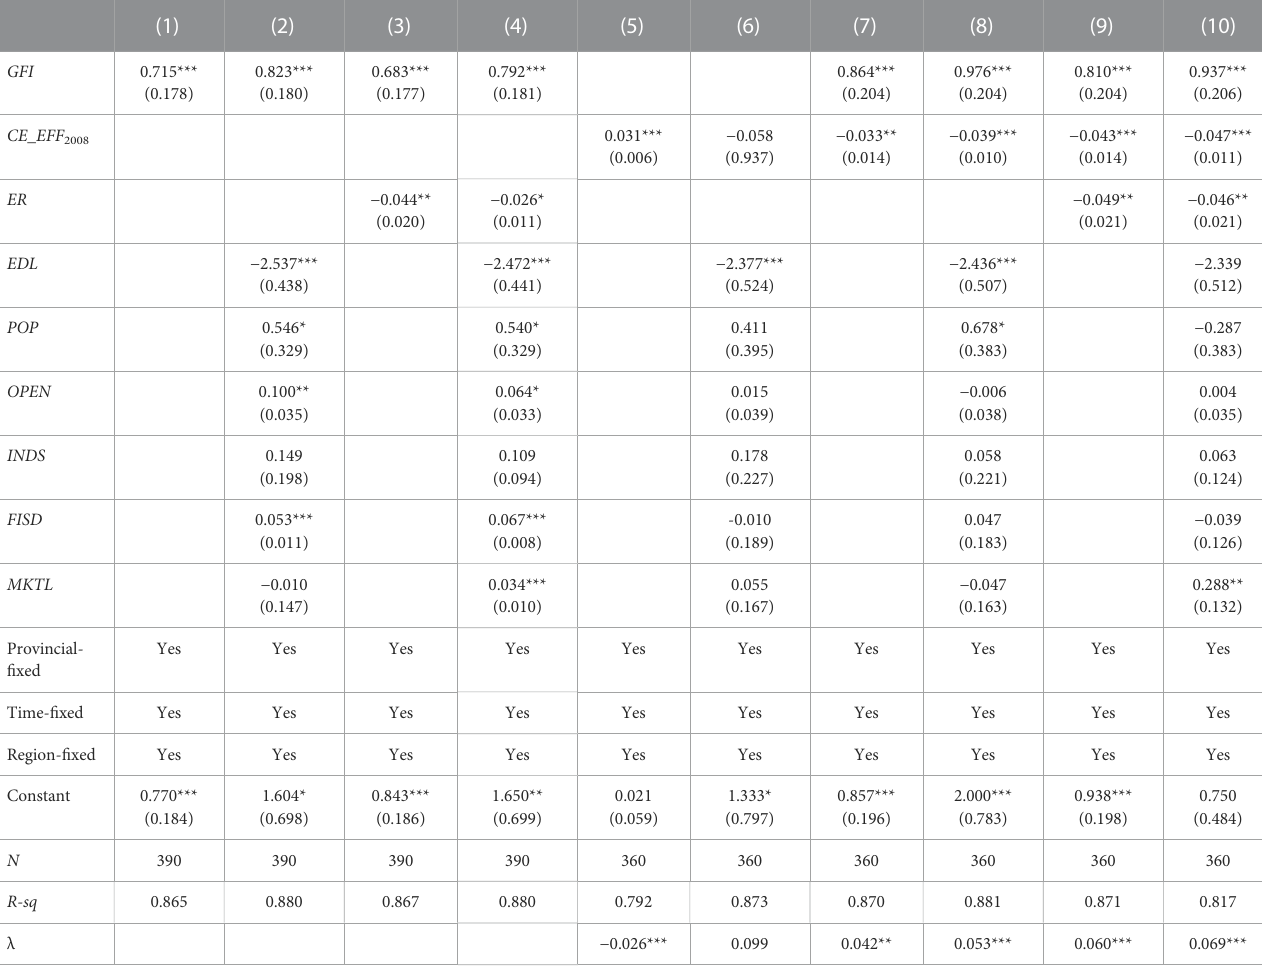
TABLE 3 Results of baseline regression and convergence